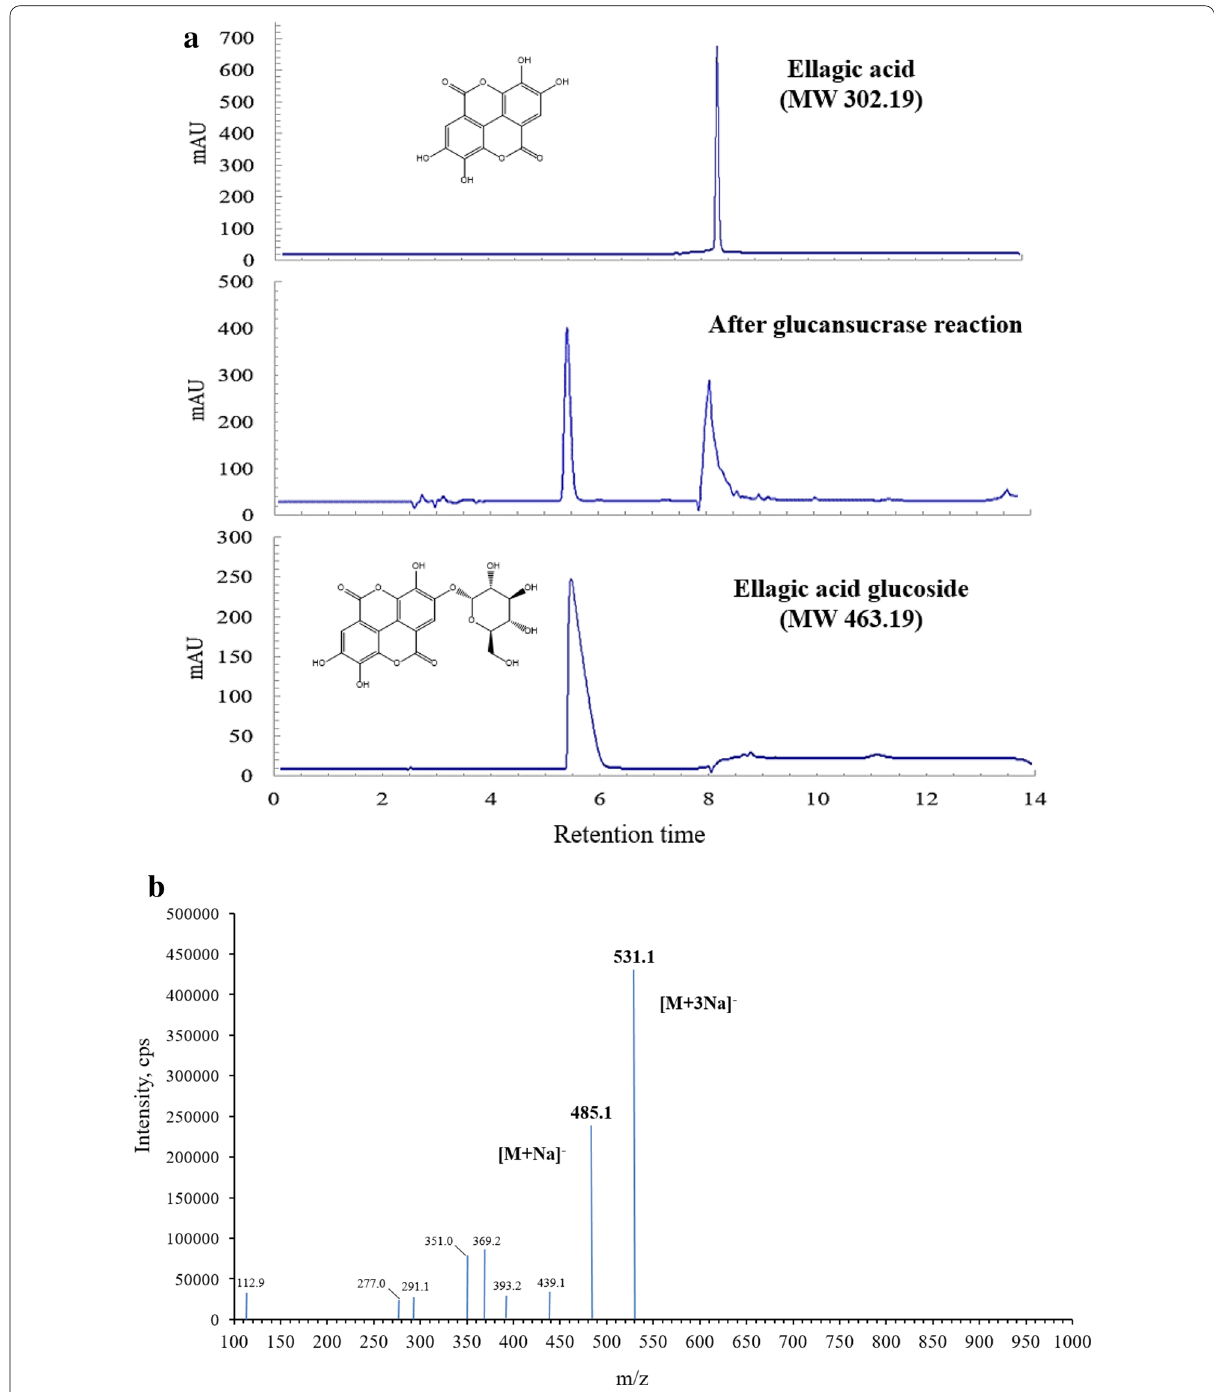
Fig. 1 HPLC chromatogram, mass spectrum, and schematic diagram of the reaction of ellagic acid and ellagic acid glucoside after column chromatography purification. Ellagic acid standard, after the reaction with glucansucrase, and purified ellagic acid glucoside ( a ), LC–MS/MS spectrum of ellagic acid glucoside ( b ), and a schematic diagram of the reaction ( c